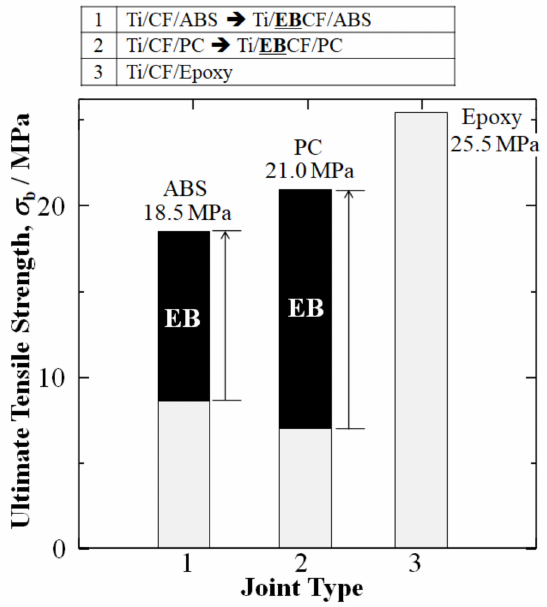
Figure 4. Improvements in ultimate tensile strength (UTS) σ b (MPa) of Ti/TP joints by HLEBI activation of CF plug closer to that of TS epoxy. Data is from: Hasegawa, Faudree, Matsumuara, Jimbo, and Nishi (2016) [10]; Hasegawa, Faudree, Enomoto, Takase, Kimura, Tonegawa, Jimbo, Salvia, and Nishi (2017) [11]; and Nishi, Uchida, Faudree, Kaneko, and Kimura (2019) [46], for titanium joints with ABS, PC, and epoxy,